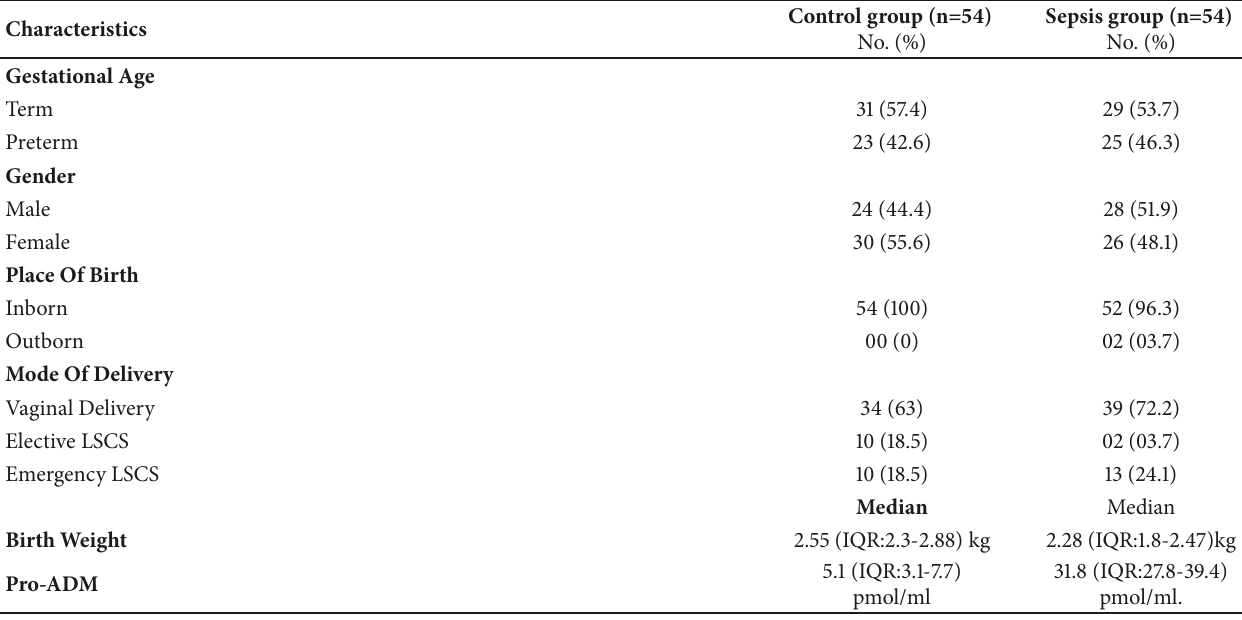
Table 1: Demographic data and Pro-ADM1 levels in the study population.